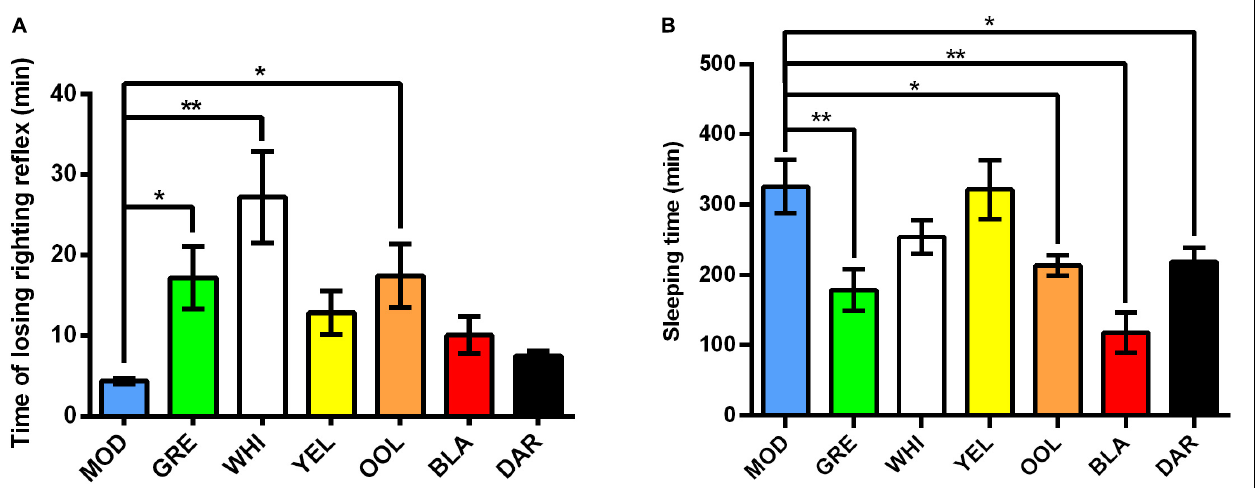
FIGURE 1 | Effect of WEATs treatment on the time of losing righting reflex (A) and sleeping time (B) . Each value represents the mean ± SEM ( n = 10). * p < 0.05 vs. MOD; ** p < 0.01 vs. MOD.